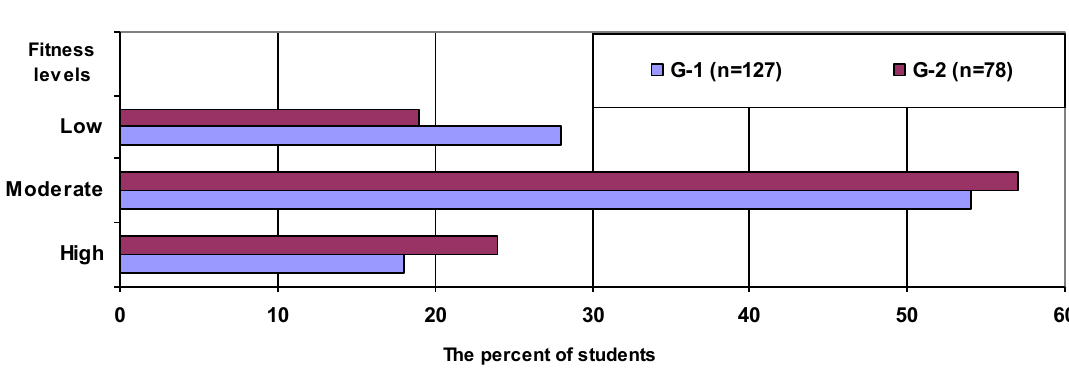
Fig. 1. Self-perceived physical fitness levels of students (G-1 and G-2).